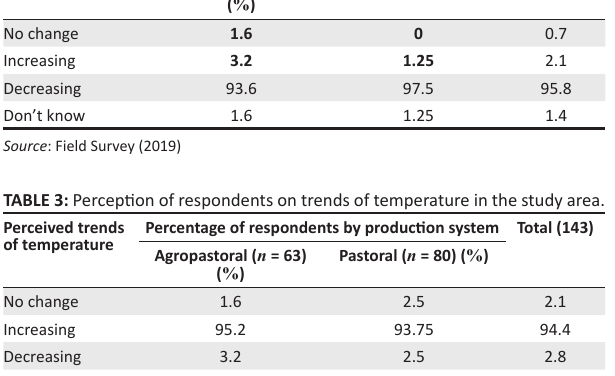
TABLE 2: Perception of the respondent on annual and seasonal rainfall trends. Perceived trends of rainfall